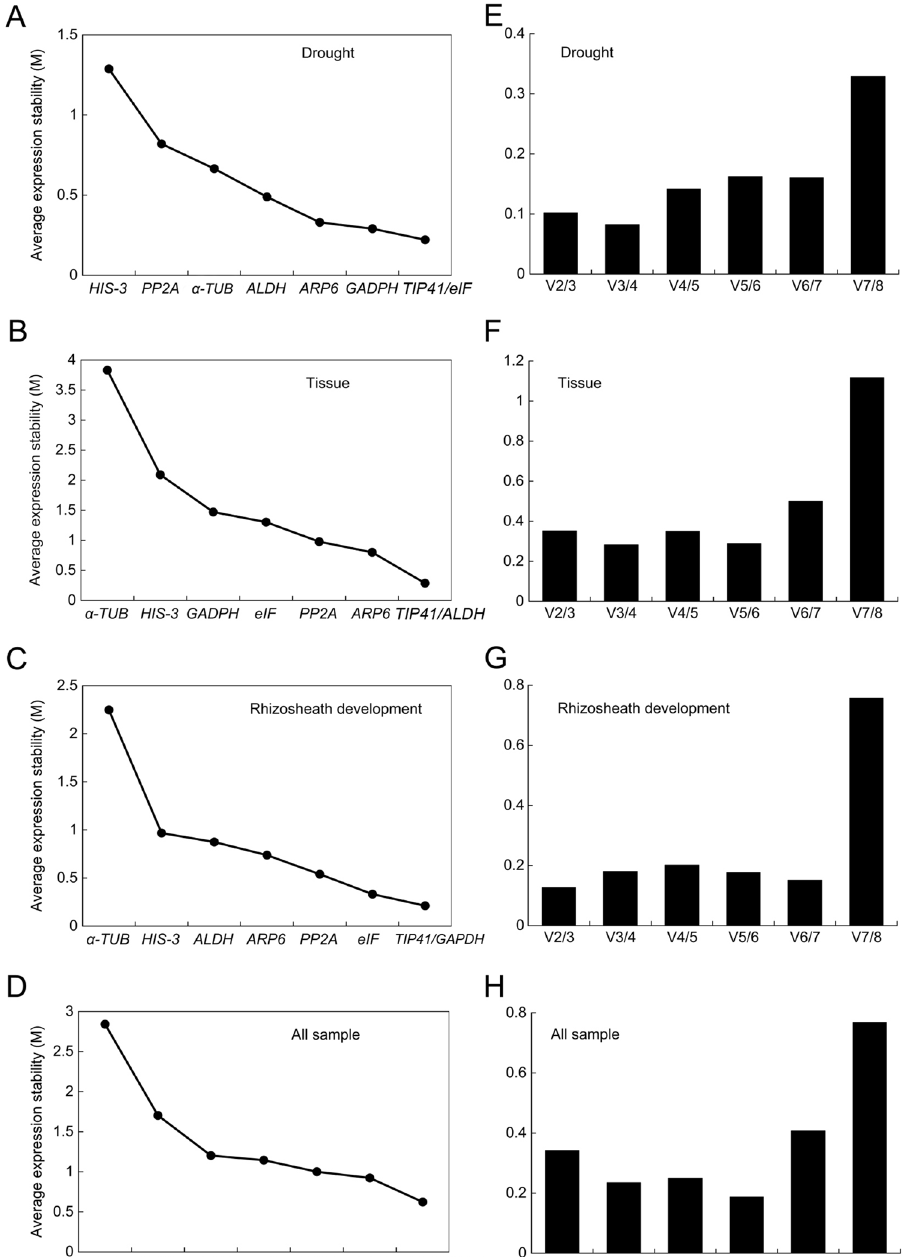
Figure 3. Stability ranking of the eight candidate reference genes based on M value and paired variation (V n / V n+1 ) value calculated by geNorm. M values represent the expression stability of each gene, with lower M value to indicate higher stability. The ratio of V n /V n+1 was used to determine the optimal reference number of multiple reference genes. M values ( A – D ) and V n /V n+1 values ( E – H ) for candidate reference genes in each group were